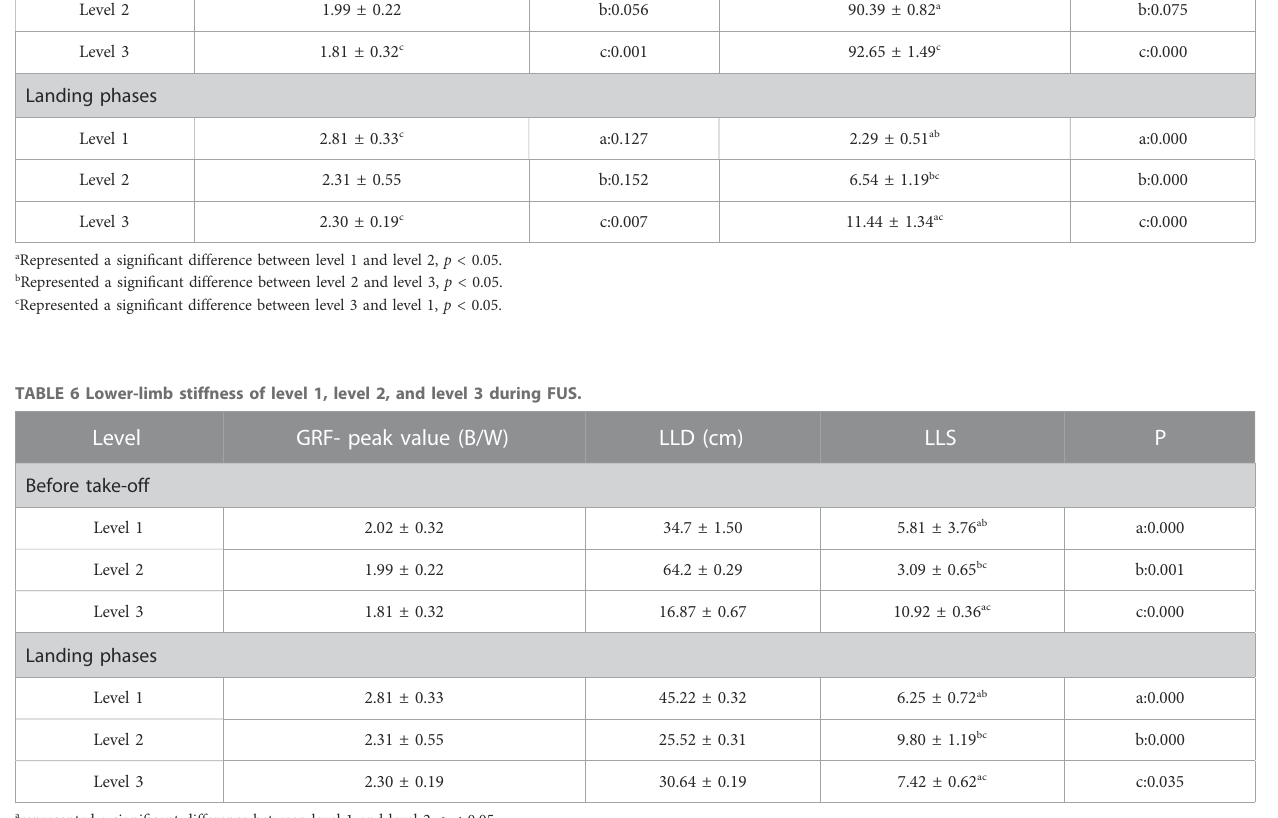
a represented a signi fi cant difference between level 1 and level 2, p < 0.05. b Represented a signi fi cant difference between level 2 and level 3, p < 0.05. c Represented a signi fi cant difference between level 3 and level 1, p <